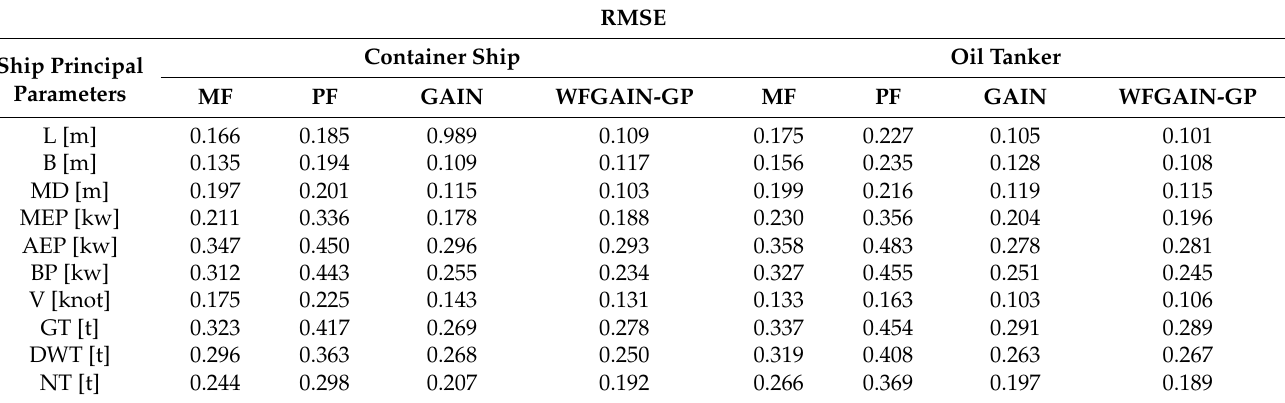
Table A5. The RMSE values of imputation based on the actual missing rate for container ship and oil tanker